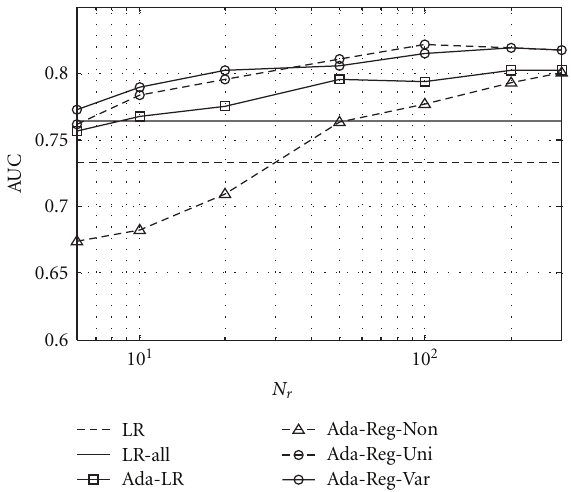
Figure 3: Classification performance (AUC) achieved by the case- adaptive classifiers with/without regularization (Ada-Reg-Non, Ada-Reg-Uni and Ada-Reg-Var). The number of retrieved cases N r was varied from 6 to 300. For comparison, results are also shown for the baseline classifier (LR), the classifier trained with all the available cases (LR-all), and the adaptive classifier in [22]